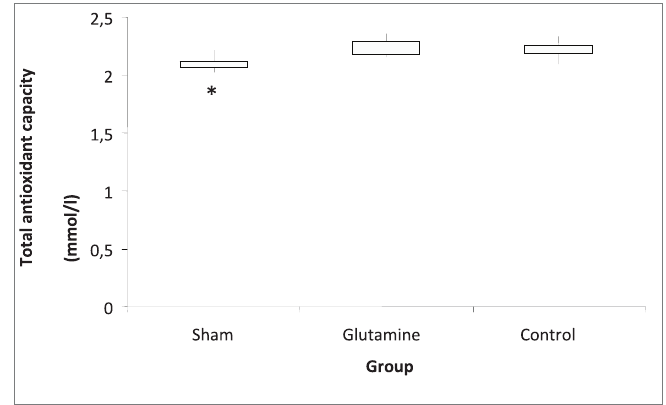
FIGURE 2 - Serum TAC in the three experimental groups. * p <0.05 vs GLN and control groups.